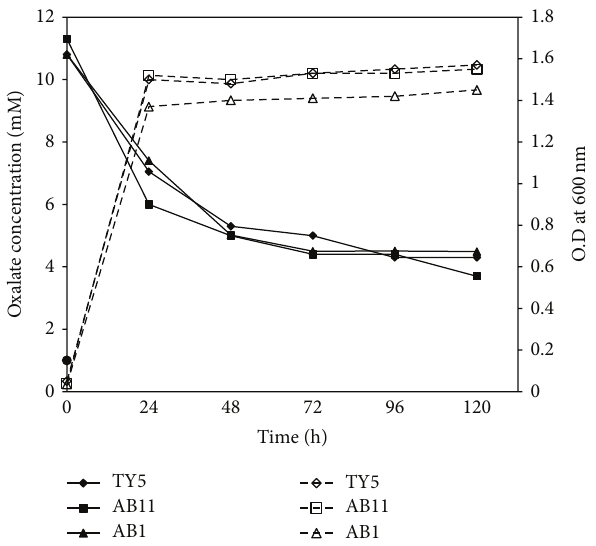
Figure 2: Kinetic analysis of oxalate degradation and growth curve of isolates in the presence of 10mM KOX. Oxalate concentration present in the supernatant (straight line) was mostly consumed during 24 h growth (dotted line) corresponding to active growth phase of